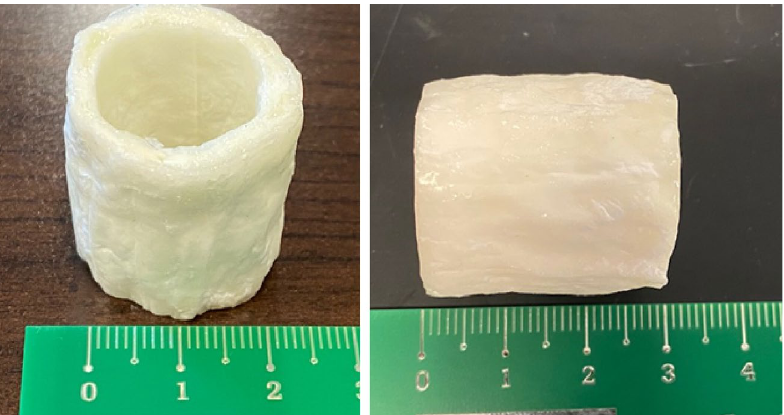
Figure 2. ( A ) pre-sterilized AG viewed obliquely; ( B ) pre-sterilized AG viewed end-on. It can be observed that the non-smooth and corrugated surface was designed to assist the surgeon during the surgery by limiting the slipping of the soft tissue over its